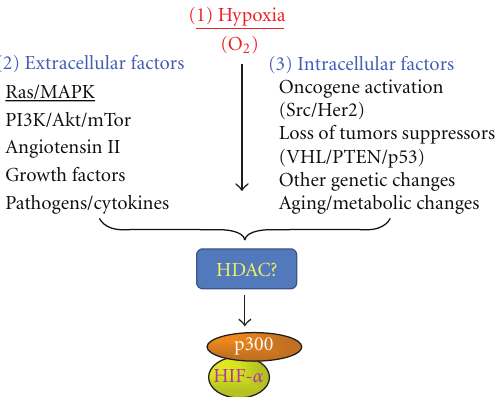
Figure 3: Multiple Signaling Pathways Regulate HIF Function and Key Determinants of the Transcription Activity of HIF-1 and HIF-2. The overall function of HIF complexes is mainly determined by protein levels of the α -subunits (HIF- α ) and their interactions with p300 or CBP. Multiple signaling pathways may modulate HIF function either through acting on HIF- α (stability or simple posttranslational modifications) or on p300/CBP (posttranslational modifications). Eventually, the HIF- α -p300 or HIF- α -CBP complexes serve as the integrators of these signals and coordinate the dynamic reprogramming of gene expression. HDACs may directly interact with the HIF transcription complexes, or indirectly or functionally interact with these signaling pathways and regulate HIF